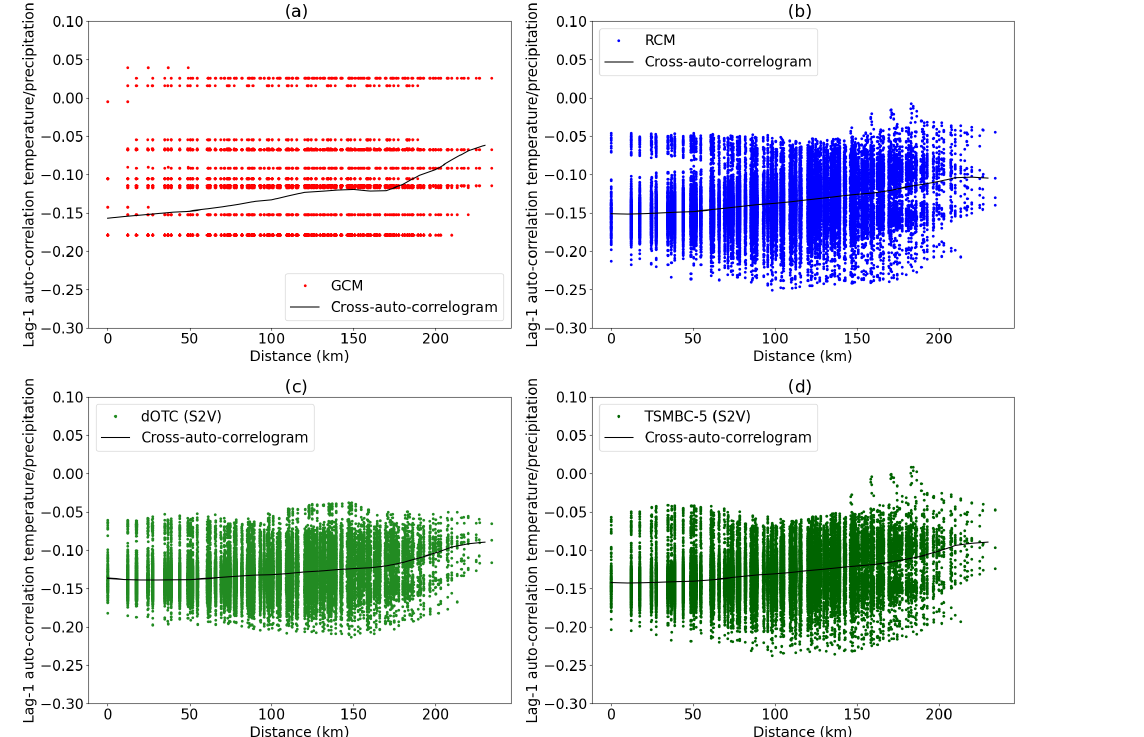
Figure 7. Auto-correlogram (lag 1) between temperatures and precipitation in calibration period in summer for (a) the model, (b) the observations, (c) the S2V dOTC correction and (d) the S2V TSMBC-5